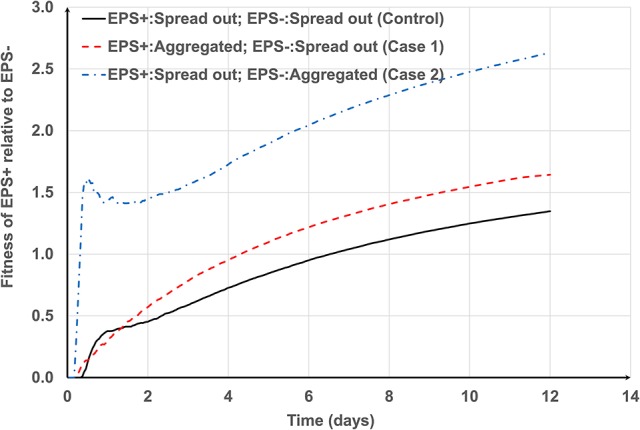
Transient variation of the fitness of EPS+ relative to EPS− at f = 0.5. The general trends for control case and Case 1 are similar. However, the fitness of EPS+ rapidly increases to 1.5 for Case 2 and then temporarily decreases and again increases at the same rate as other cases.